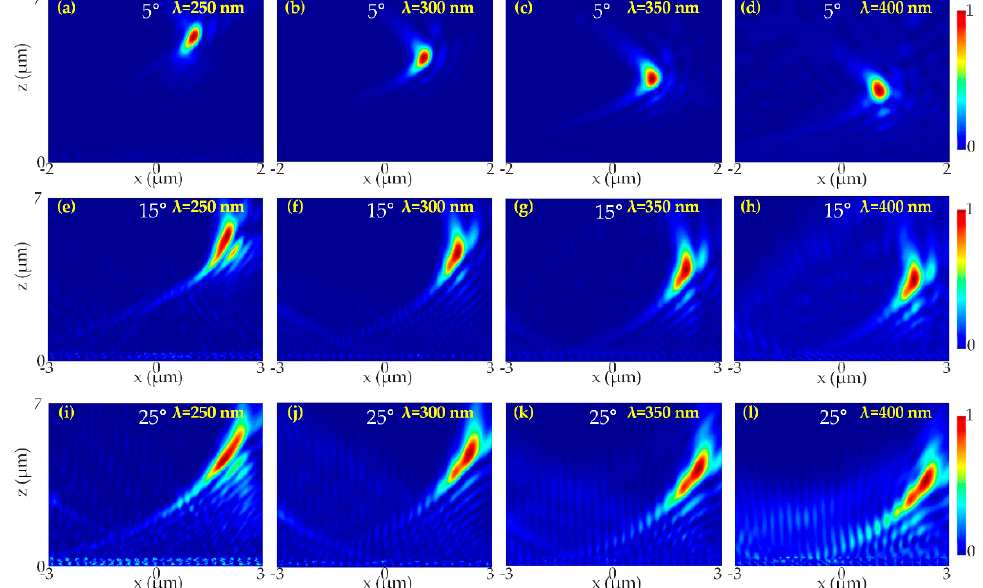
Figure 6. Focusing characteristics of UV metalens at 250–400 nm at different incident angles. Normalized intensity distribution at x-z plane at an incident angle of 5 ° (a) λ = 250 nm, (b) λ = 300 nm, (c) λ = 350 nm and (d) λ = 400 nm. Normalized intensity distribution of the metalens at x-z plane at an incident angle of 15 ° (e) λ = 250 nm, (f) λ = 300 nm (g) λ = 350 nm and (h) λ = 400 nm. Normalized intensity distribution at x-z plane at an incident angle of 25 ° (i) λ = 250 nm (j) λ = 300 nm (k) λ = 350 nm and (l) λ = 400 nm